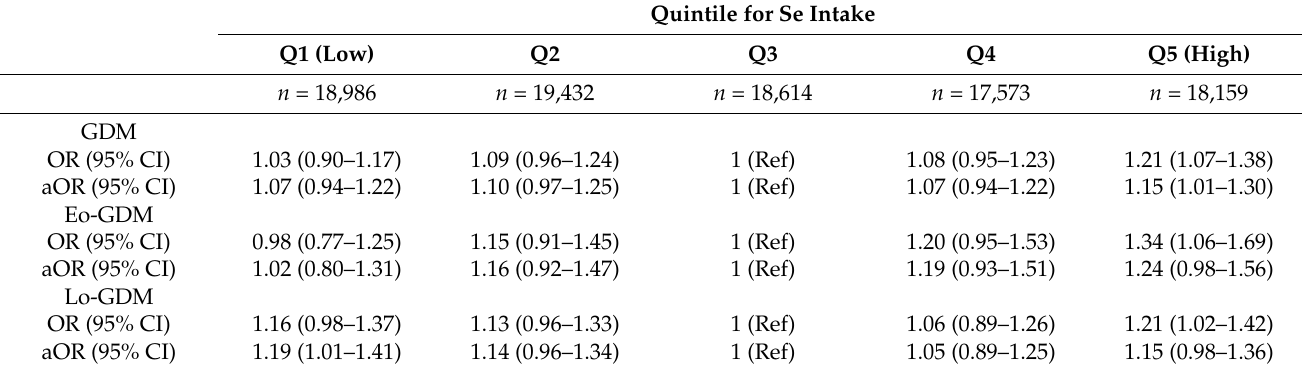
Table 3. Relationship between preconception Se intake and